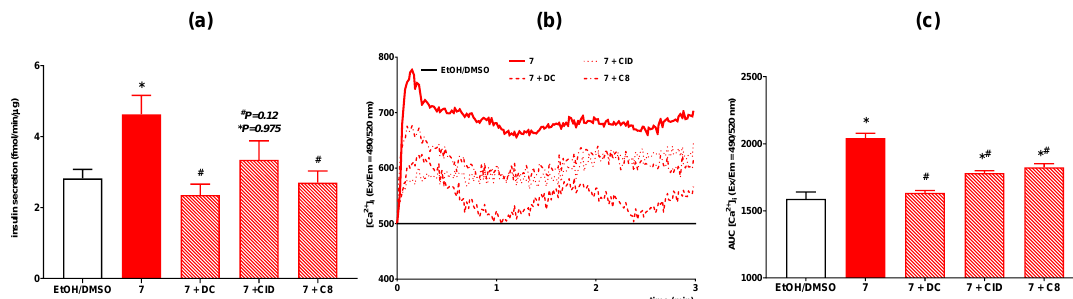
Figure 7. Insulin secretion ( a ) and intracellular Ca 2+ mobilization (( b ) kinetic read, ( c ) AUC) in MIN6 cells at 20 mM glucose conditions stimulated with 7 against GPR40, GPR55, and GPR119 antagonists (depicted as DC, CID, and C8 respectively). p < 0.05 for insulin secretion and [Ca 2+ ] i mobilization significantly different from EtOH/DMSO control (*) and from MIN6 cells untreated with receptor antagonists ( # ).